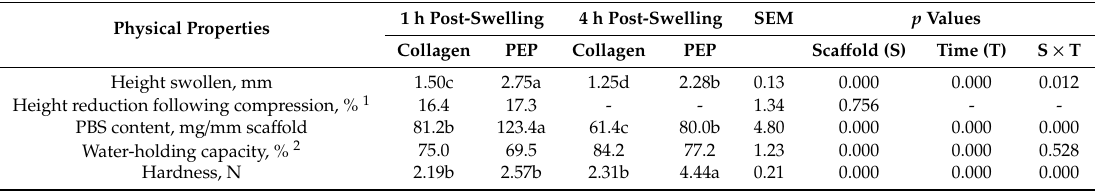
Table 1. Physical sca ff old properties.